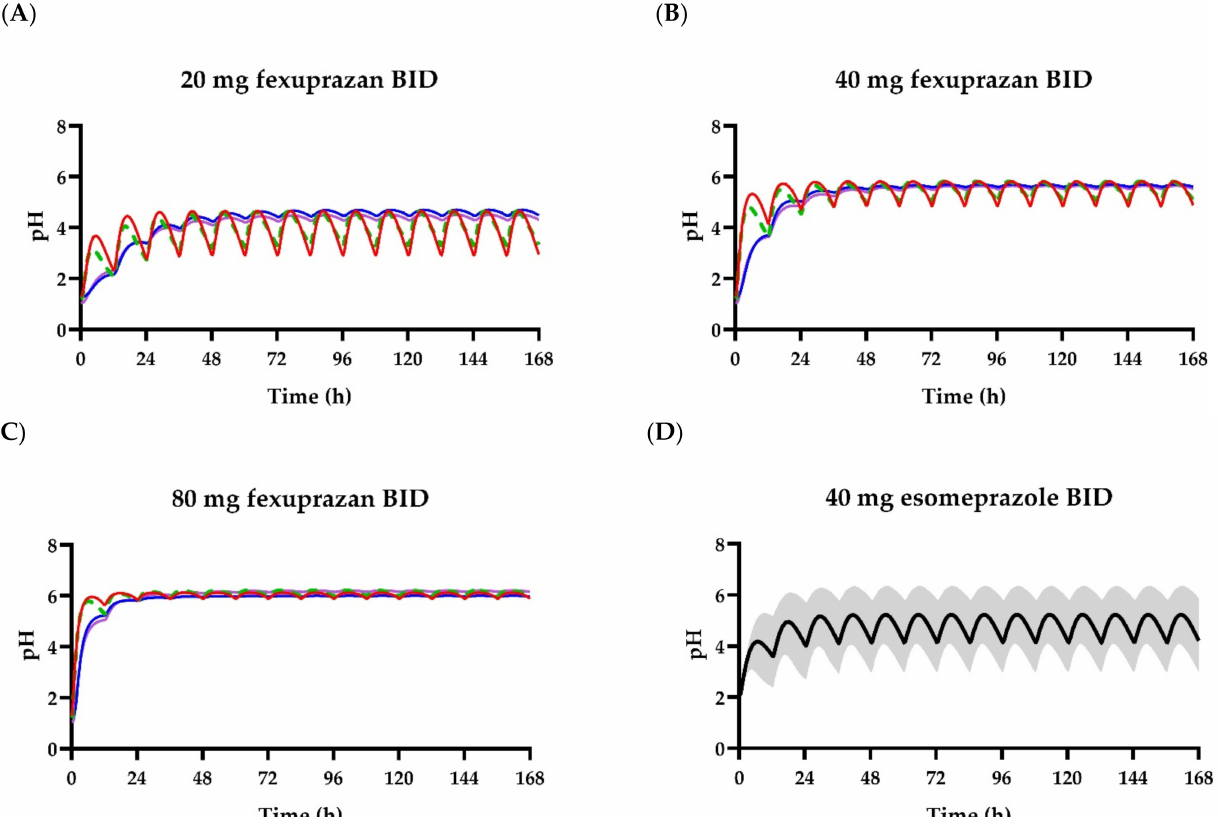
Figure 5. Simulated intragastric pH profiles for fexuprazan and esomeprazole BID. Time-pH profiles are shown after fexuprazan 20 mg BID ( A ), 40 mg BID ( B ), and 80 mg BID ( C ), as well as esomeprazole 40 mg BID ( D ). Red, green (dashed), blue, and purple lines represent Scenarios A, B, C, and D for fexuprazan, respectively (see text). The black solid line is the median of simulated pH after the oral administration of esomeprazole (40 mg BID) in the virtual population. Gray shadow is the 90% range of the predicted